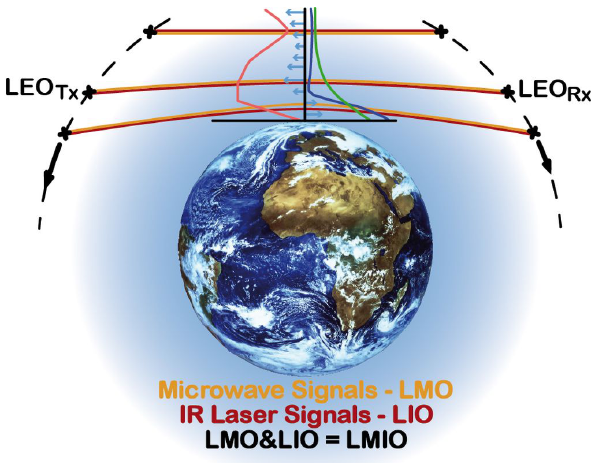
Fig. 1. Overview of the measurement concept of the ACCURATE Fig.1. OverviewofthemeasurementconceptoftheACCURATEsatellitemissionapplyingtheLMIOmethod. satellite mission applying the LMIO